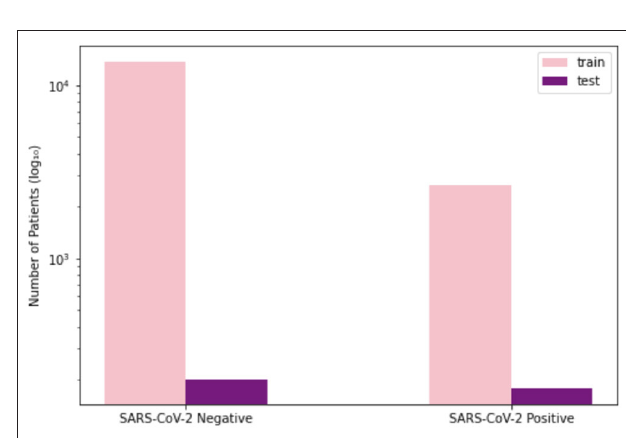
FIGURE 2 | Image-level distribution of benchmark dataset for SARS-CoV-2 negative and positive cases. (Left) Number of training images, (Right) number of test images.